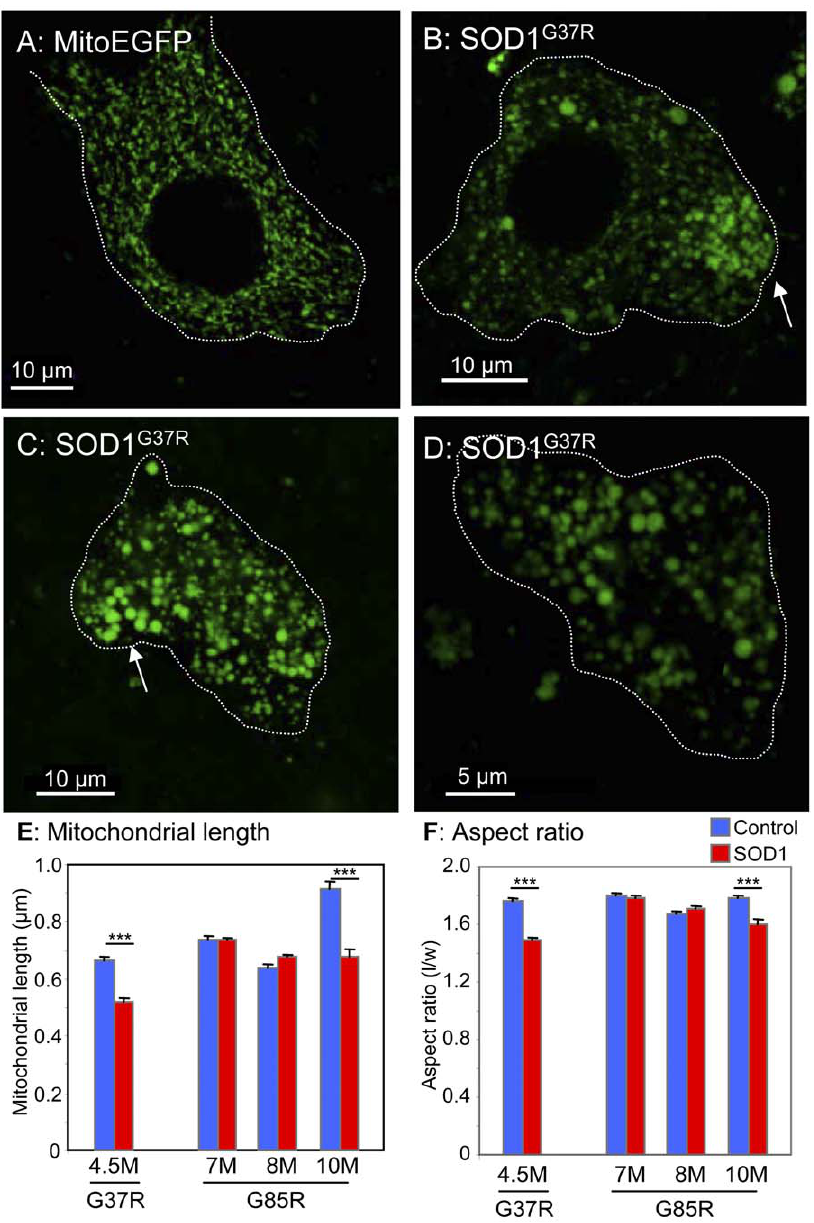
Figure 3. Motor neuron mitochondria are rounder in mutant SOD1 mice. MitoEGFP ( green ) expression in spinal cord motor neurons in control MitoEGFP (A) and SOD1 G37R early symptomatic animals (B–D). The control neuron has normal mitochondria of diverse shapes and sizes. In contrast, SOD1 G37R motor neurons have rounded swollen mitochondria with uneven distribution. Arrows indicate possible axon hillocks. Motor neuron boundaries have been outlined with dotted line. Quantification of mitochondrial length (E) and aspect ratio (F) in motor neuron cell bodies of mutant SOD1 animals of various ages and age-matched MitoEGFP control animals. ***, p , 0.0005. Scale bars, 10 m m. doi:10.1371/journal.pone.0022031.g003 found in axons from both SOD1 mutants ( Fig. 5E–G ), consistent with increased mitochondrial fission and/or decreased fusion.